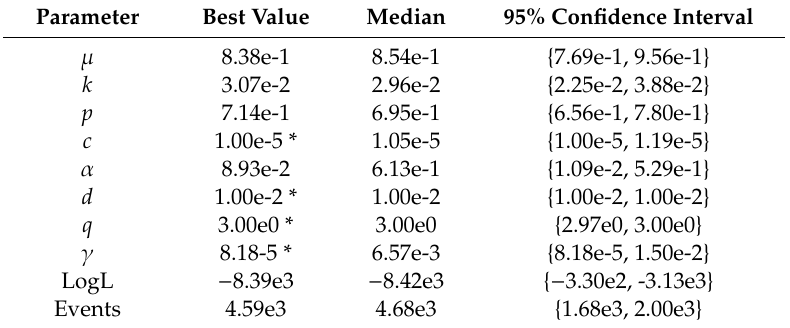
Table 10. Parameter estimates for East Africa. Estimation results for the 8 parameters of the ETAS model, the log likelihood and the number of events for the East Africa conflict catalog. Estimates marked with a * are at, or very close to, their constraint values. The best estimate, that is, the estimate of the run with the highest log likelihood, is given for each parameter. Furthermore, the median and the 95% confidence intervals are given.